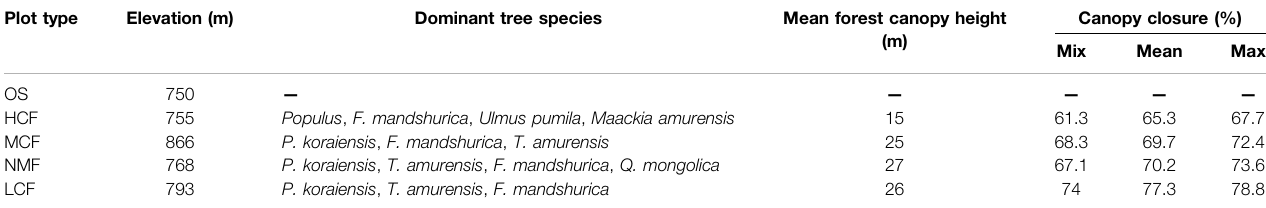
TABLE 1 | Detailed information of forest